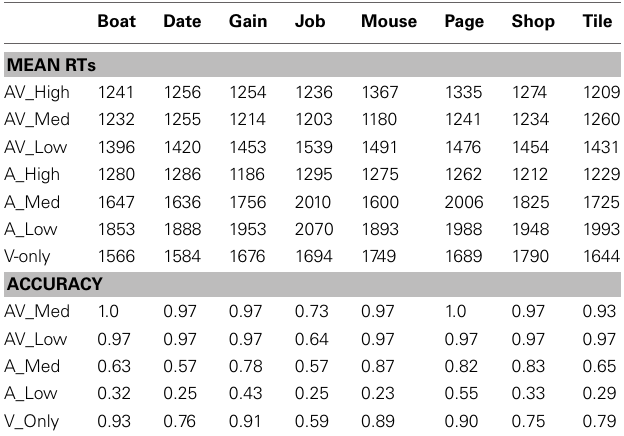
Table displaying the mean accuracy and RTs for the 8 words averaged across participants [RT outliers greater than 3000 ms were removed, as was also done in the C(t) analyses]. Overall, mean RTs and accuracy were consistent across stimuli within any given condition. Some noticeable exceptions include the mean RTs for “Job” and “Page” relative to the other stimuli in the “A_Med” ( − 12 dB) condition. One explanation for this particu- lar finding was that the stimuli was that “Job” was often confused with “Shop,” leading to lower mean AV and A accuracy (in the − 12 and − 18 dB conditions) and longer RTs compared the other stimuli. Nonetheless, the same trend of faster audiovisual vs. auditory or visual-only RTs was observed for all stimuli (includ- ing “Job”), in the − 12 and − 18 dB conditions. These mean RT and accuracy data add converging evidence to the capacity and “Gain” data, which indicate considerable audiovisual benefit in lower S/N ratios, and absence of benefit in optimal listening